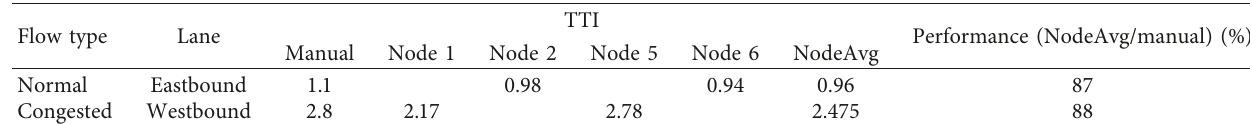
Table 2: TTI performance